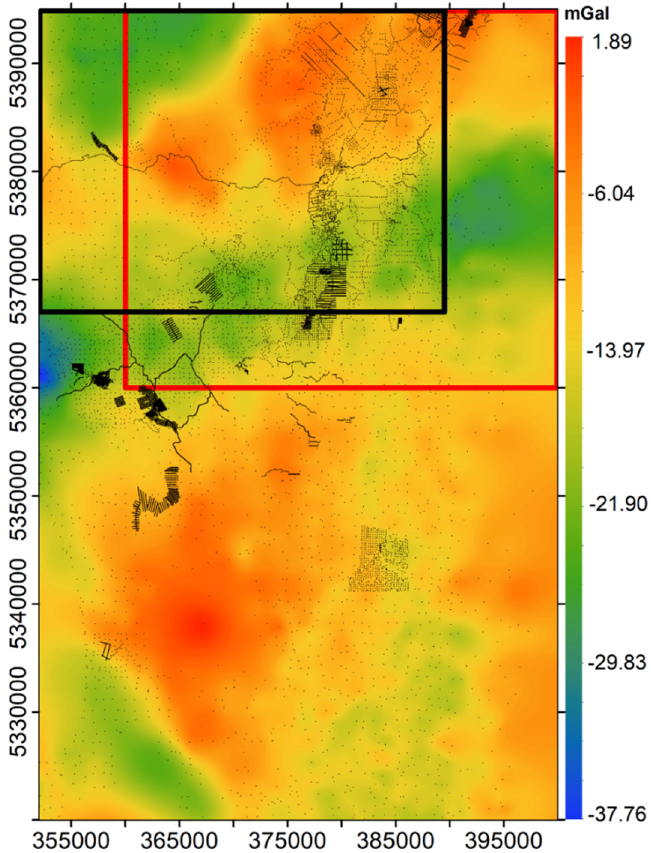
Figure 8. Illustrates the observed gravity response (mGal; including gravity stations, black dots) highlighting the response of the various lithologies that contribute to the local gravity field. Red and black rectangles represent the Rosebery Region and Rosebery–Pieman study area, respectively. The full grid represents the Rosebery–Lyell 3D model extents.